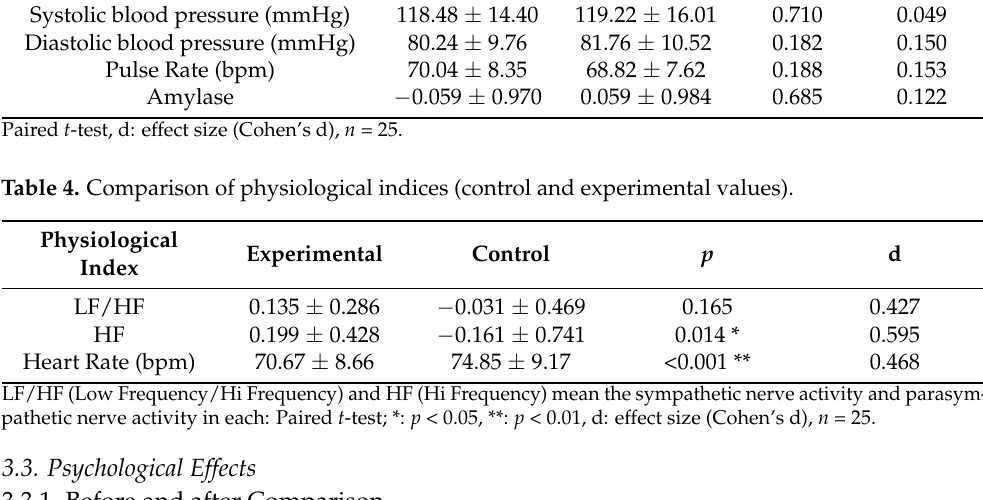
Table 3. Comparison of physiological indicators (before and after the experience). Physiological Index Before After p Systolic blood pressure (mmHg)